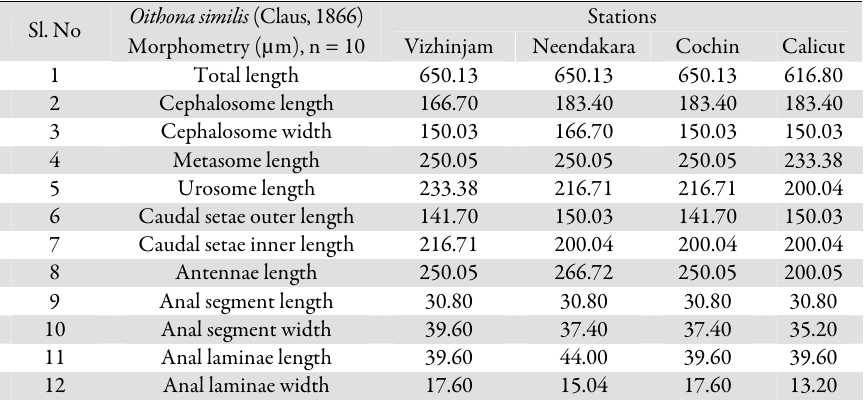
Tab. 2. Setal formula of the exopod (outer and inner margins) and endopod of the four legs (P